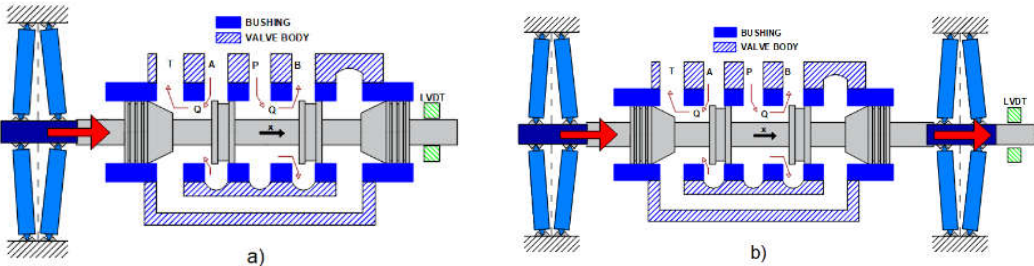
Figure 2. Two schemes of application of amplified piezo-stack actuators with diamond structure for the direct actuation of a 4/3 servovalve: ( a ) one actuator; ( b ) two actuators.